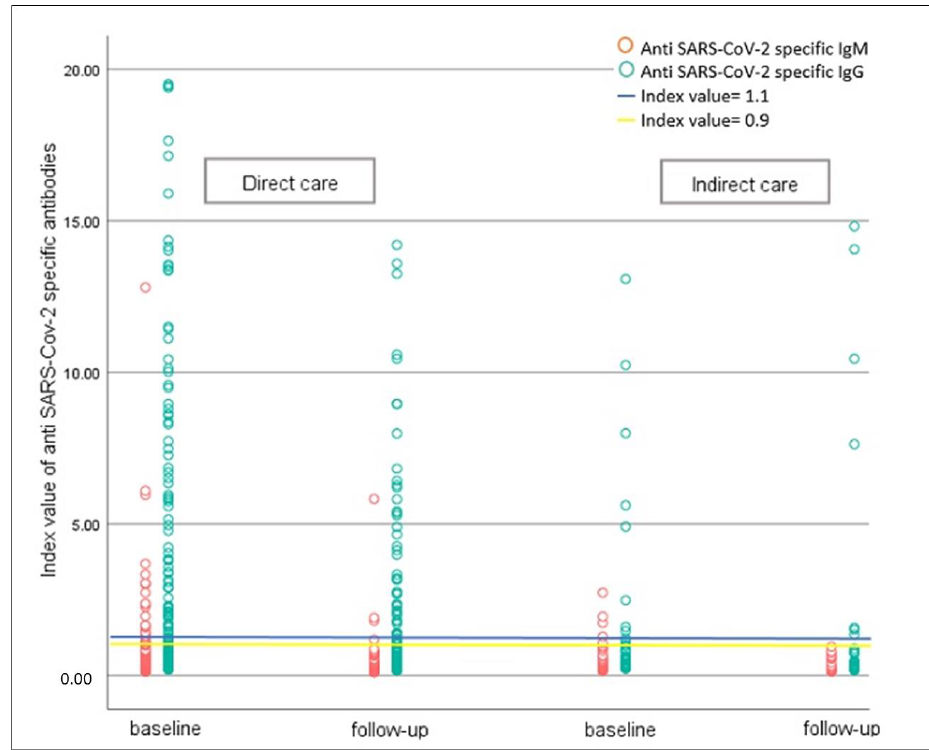
Figure 3. Index value of serum Anti SARS-CoV-2 specific IgG and IgM in two groups of direct and indirect contact; each circle represents one HCW. The blue and yellow lines represent cut-off index values of 1.1 and 0.9, respectively. Table 3. Frequency of reported symptoms in preceding months in HCWs based on